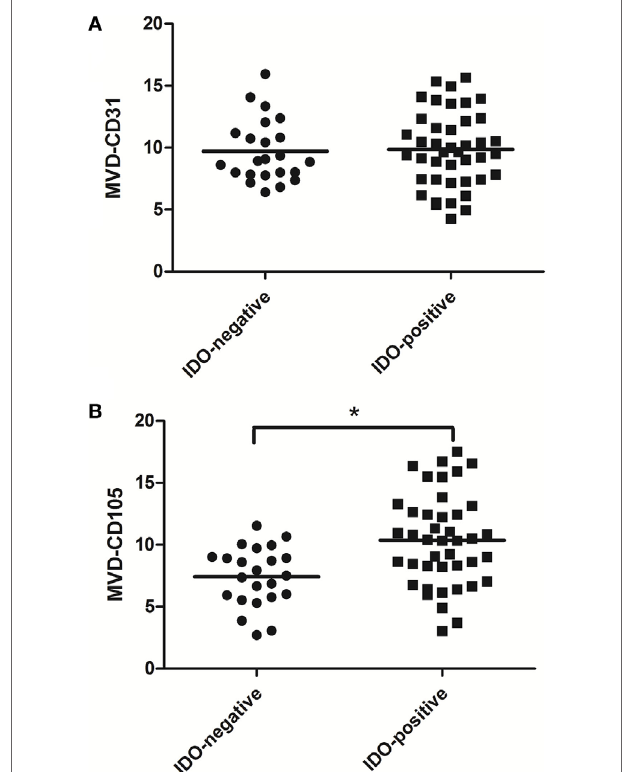
FigUre 2 | Scatter plot of microvessel density (MVD)-CD31 level and MVD-CD105 level in breast cancer tissue with indoleamine 2,3-dioxygenase (IDO) negative and positive expression. The MVD-CD105 level was higher in tissue with IDO positive than IDO negative (B) , whereas MVD-CD31 did not differ in IDO-expressing and non-expressing tissues (a) .